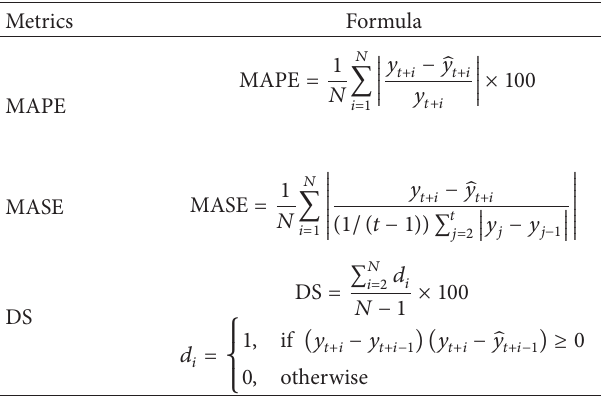
Table 1: Performance metrics and their formulas in regression problems.